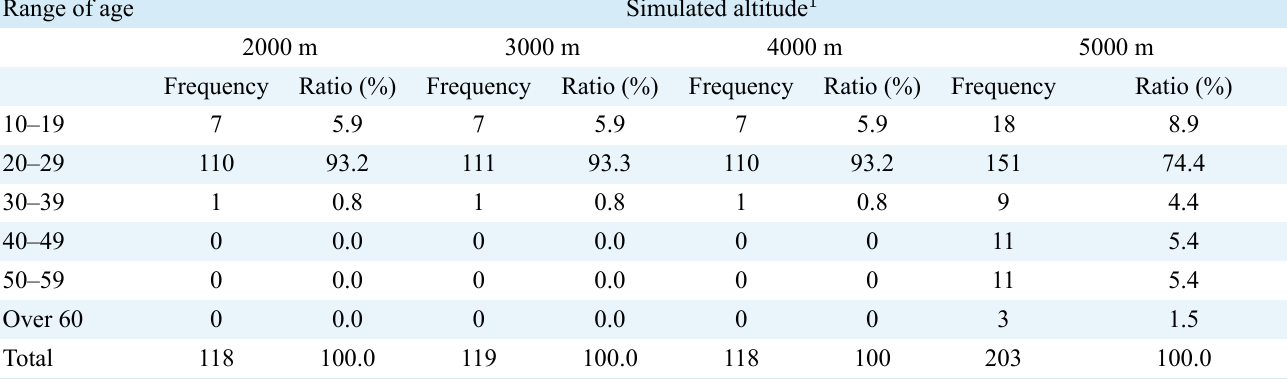
TABLE 1. The subject’s age distribution.